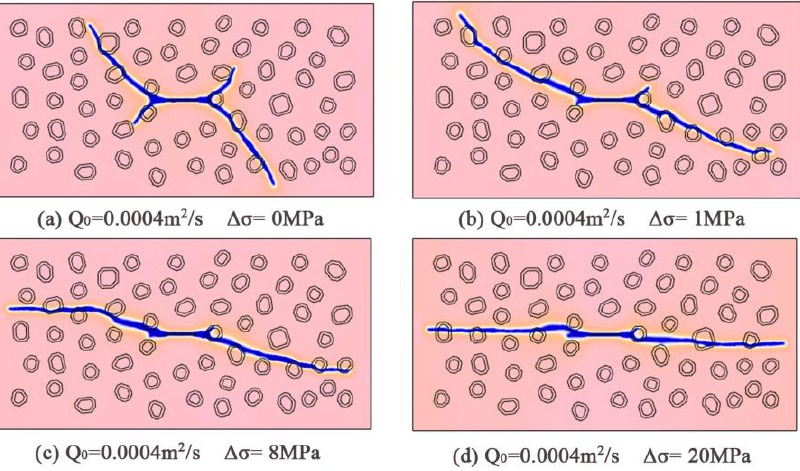
Figure 7. Fracture evolution under different stress differences. ( a ) ∆ σ = 0 Mpa; ( b ) ∆ σ = 1 MPa; ( c ) ∆ σ = 8 MPa; ( d ) ∆ σ = 20 MPa.